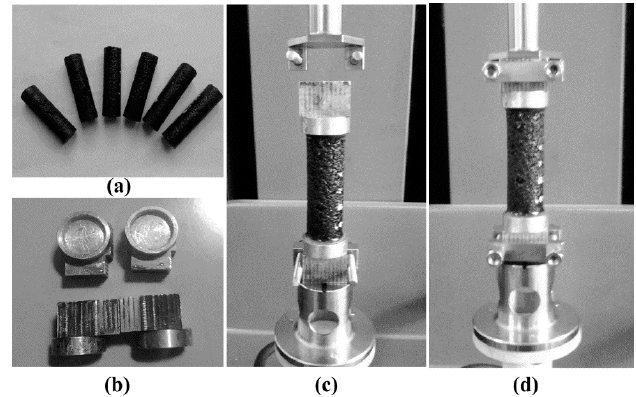
Figure 5. FAM cylinders and set-up: ( a ) six types of FAM cylinder, ( b ) joint bases, ( c ) one base with